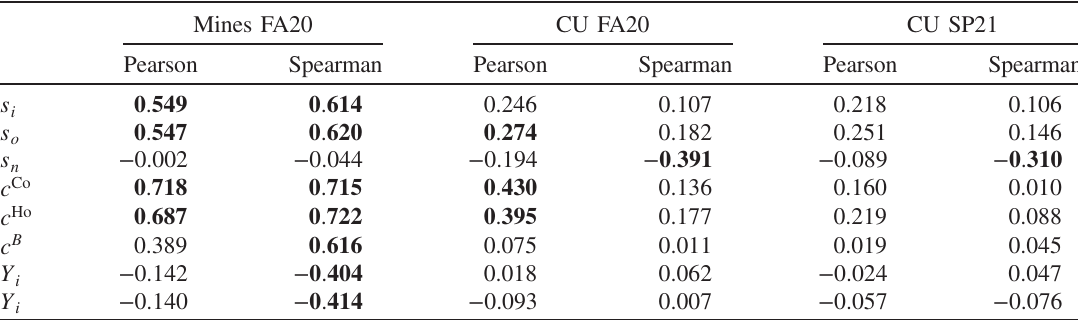
TABLE V. Pearson and Spearman correlation between homework grades and centralilty measure in each of the three courses analyzed in this study. Statistically significant correlations (at the p < 0 . 05 level) are indicted in